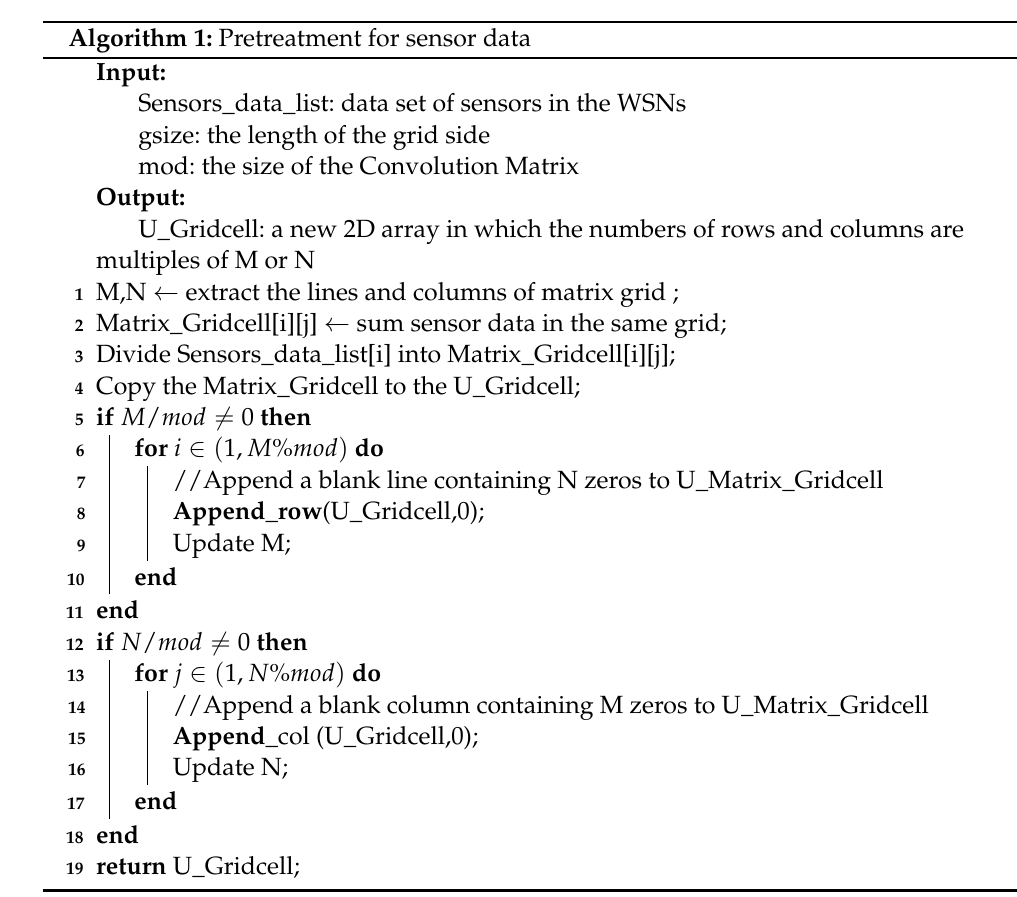
Algorithm 1: Pretreatment for sensor data